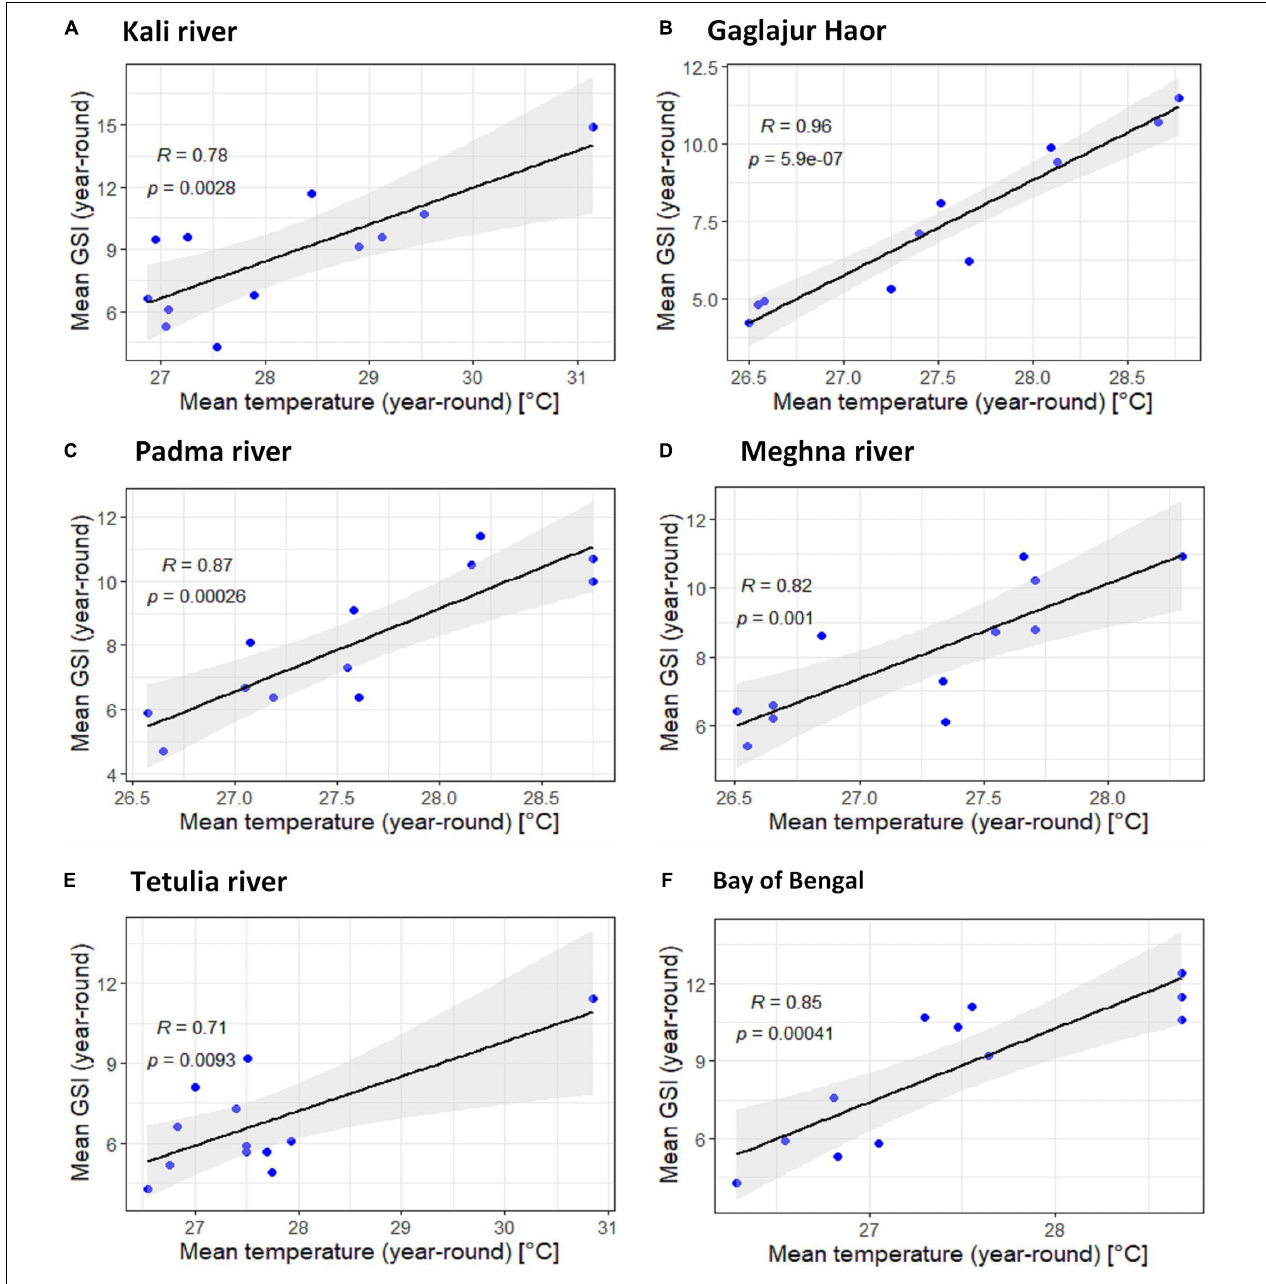
FIGURE 5 | Scatter plot and linear regression for the year-round means of Gonadosomatic index (GSI) of Tenualosa ilisha against mean temperatures for six diverse habitats across Bangladesh: (A) Kali river, (B) Gaglajur Haor, (C) Padma river, (D) Meghna river, (E) Tetulia river, and (F) Bay of Bengal. Pearson correlation coefficient is reported as “R” while probability value is reported as